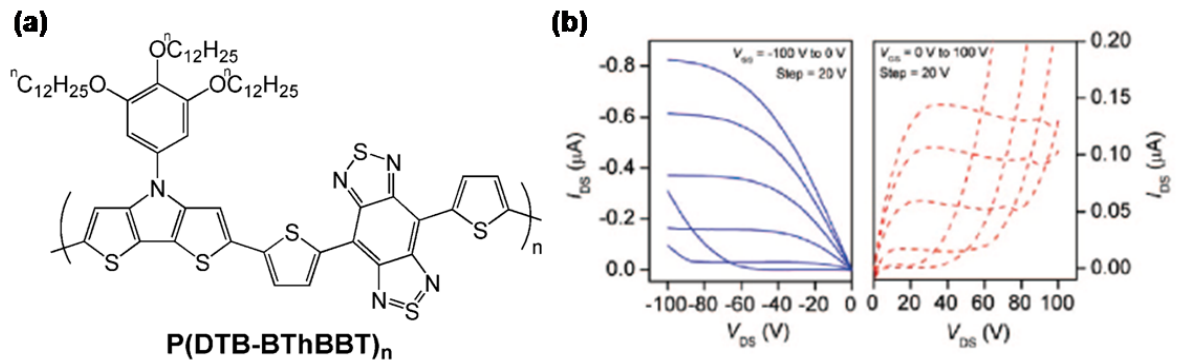
Figure 15. (a) Chemical structure of semiconducting copolymer P(DTP-BThBBT) (b) Output characteristics; p-channel operation (left) is measured in a device annealed at 110 °C; n-channel operation (right) is measured in a device annealed at 150 °C. Reproduced with permission from reference [72]. Copyright 2009 American Chemical Society.